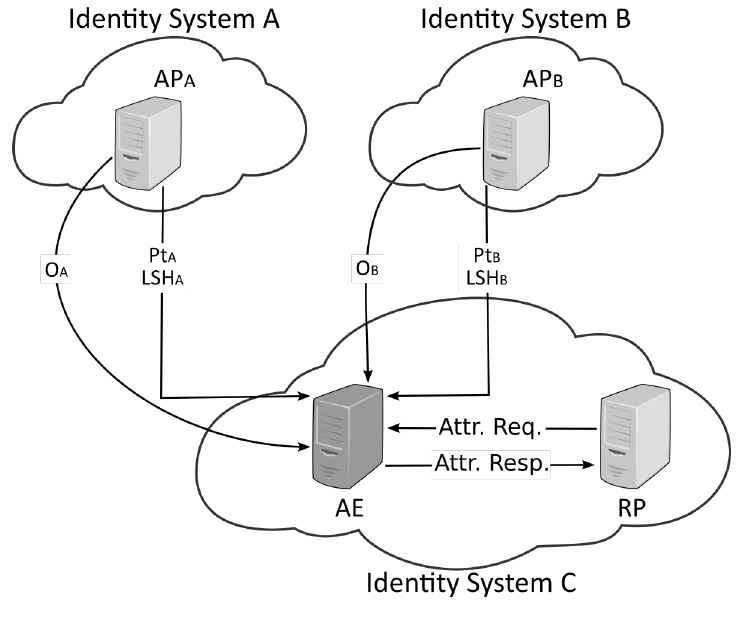
Figure 1. General